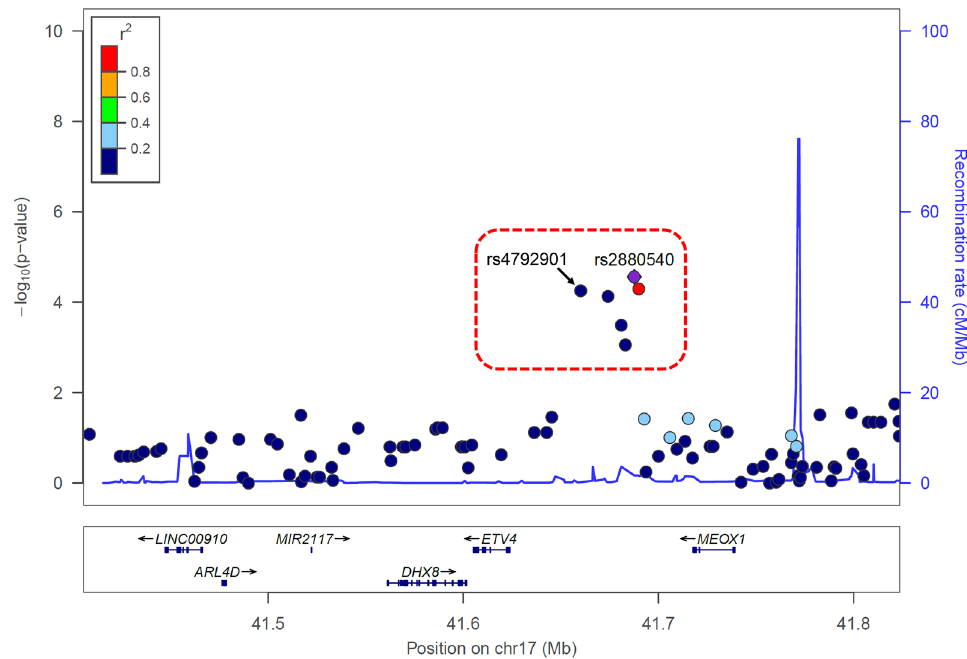
Figure 1. Association of SNPs in the ETV4 region with asthma. The association study was carried out by logistic regression analysis adjusted for gender, age, and smoking status (never, ex, or current). The associations of the SNPs in a region spanning 200 kb upstream and downstream of the ETV4 gene are plotted. The position on chromosome 17 is shown on the x-axis. The y-axis shows the statistical significances (− log 10 [ P -value]). The purple diamond is the most significant rs2880540 SNP. All the other circle SNPs are color-coded according to the levels of linkage disequilibrium (LD) with rs2880540. The Genome Build/LD population is hg19/1000 Genomes Nov 2014 ASN. The relative location of genes and the direction of transcription are shown in the lower portion. The red dotted-line square indicates a cluster of six SNPs significantly associated with asthma.